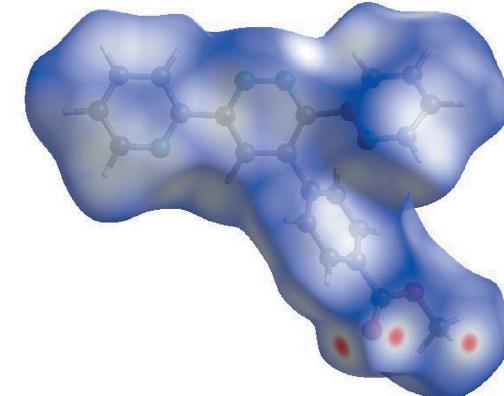
Figure 1 The molecular structure of the title compound with the atom-numbering scheme. Displacement ellipsoids are drawn at the 50% probability level.